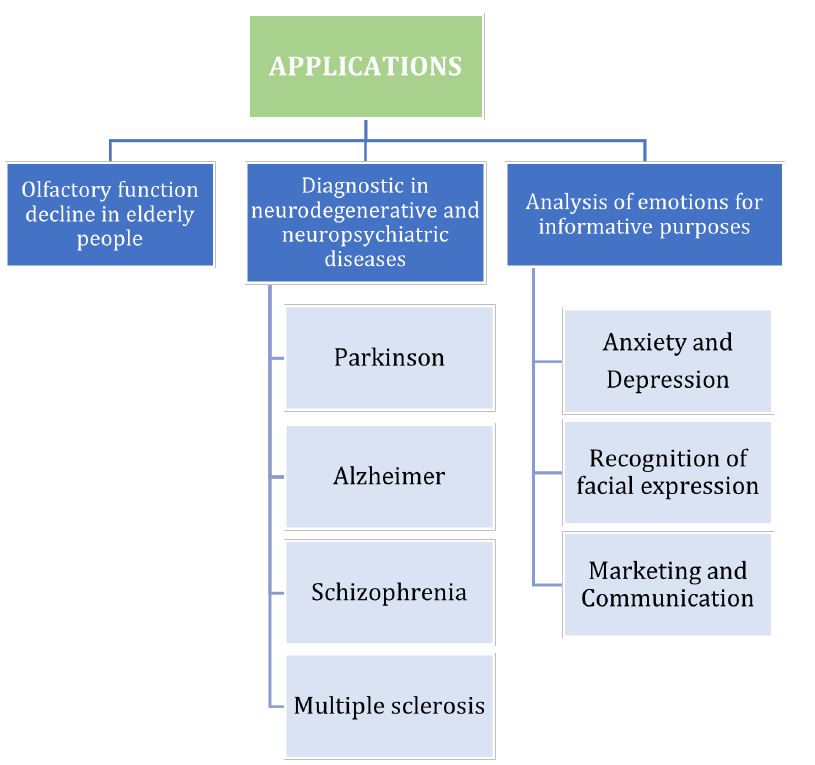
Figure 4. Taxonomy of the potential and application fields of OERP, resulting from the review of the